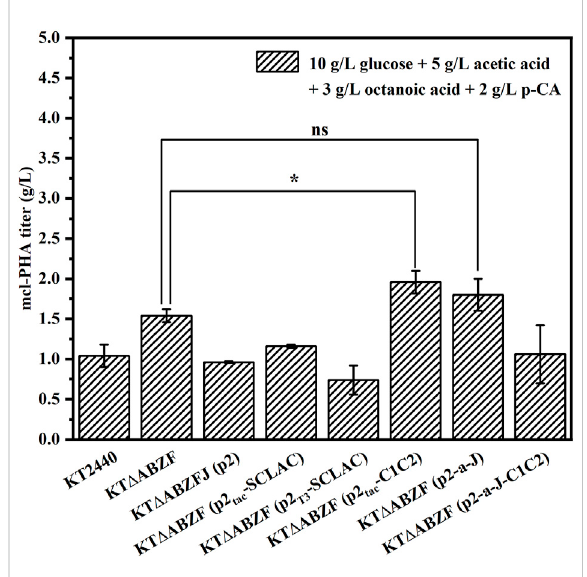
FIGURE 3 The performance of mcl-PHA production by the engineered P. putida using 10 g/L glucose, 5 g/L acetic acid, 3 g/L octanoic acid and 2 g/L p-CA as mixed substrates. The engineered P.